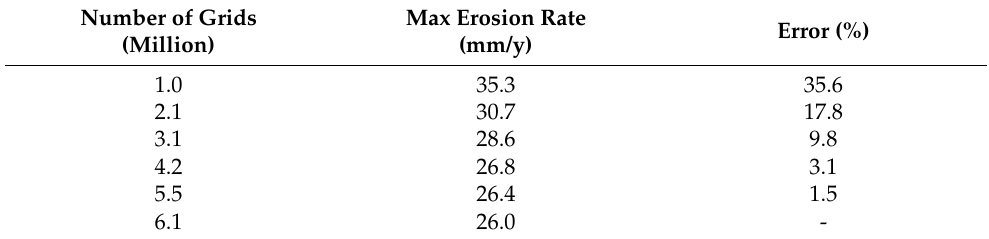
Table 4. Validation of the grid independence of the elbow with corrosion holes.